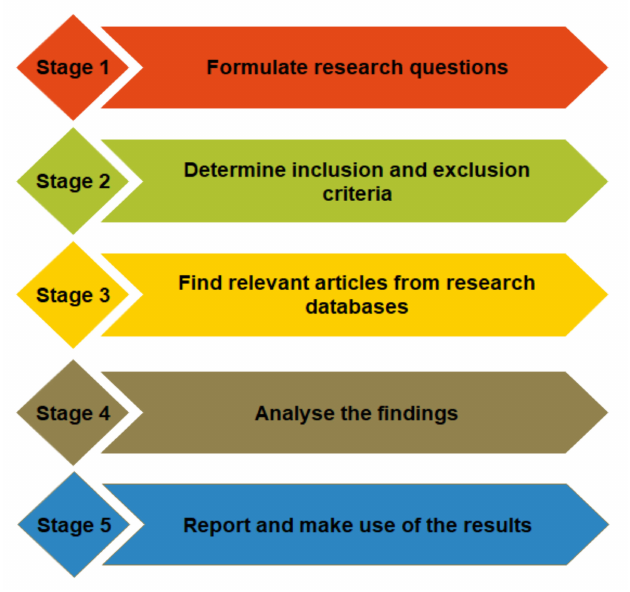
Figure 3. Stages of conducting a systematic literature